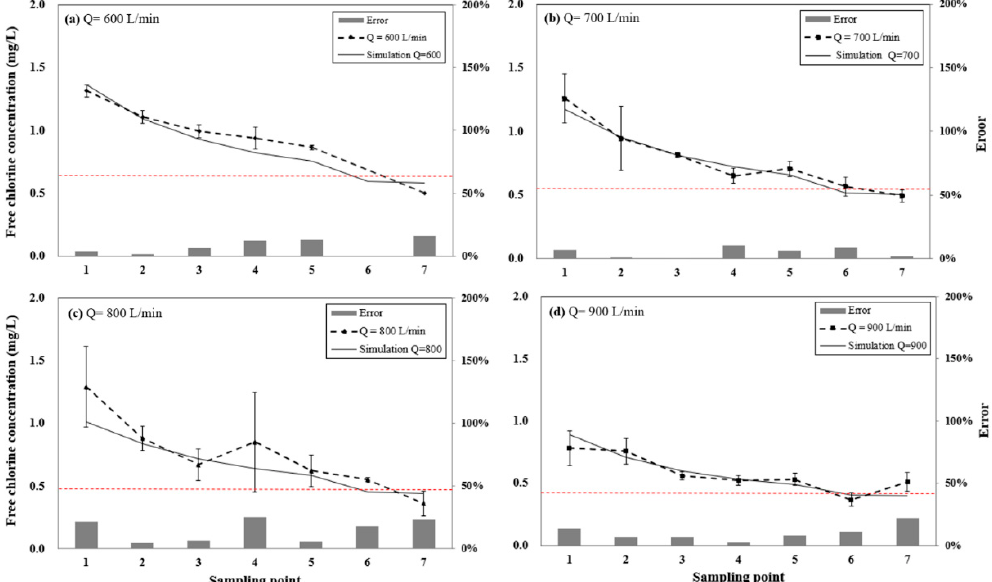
Figure 6. Free chlorine distribution along the sampling ports under different flow rates. Each dot represents experimental data, and each point on the black line is the expected chlorine concentration obtained from computational fluid dynamics (CFD) simulation with a parallel first-order decay model. The red-dotted line is the desirable concentration at the given flow rate: ( a ) 600 L min − 1 of flow rate, ( b ) 700 L min − 1 of flow rate, ( c ) 800 L min − 1 of flow rate, ( d ) 900 L min − 1 of flow